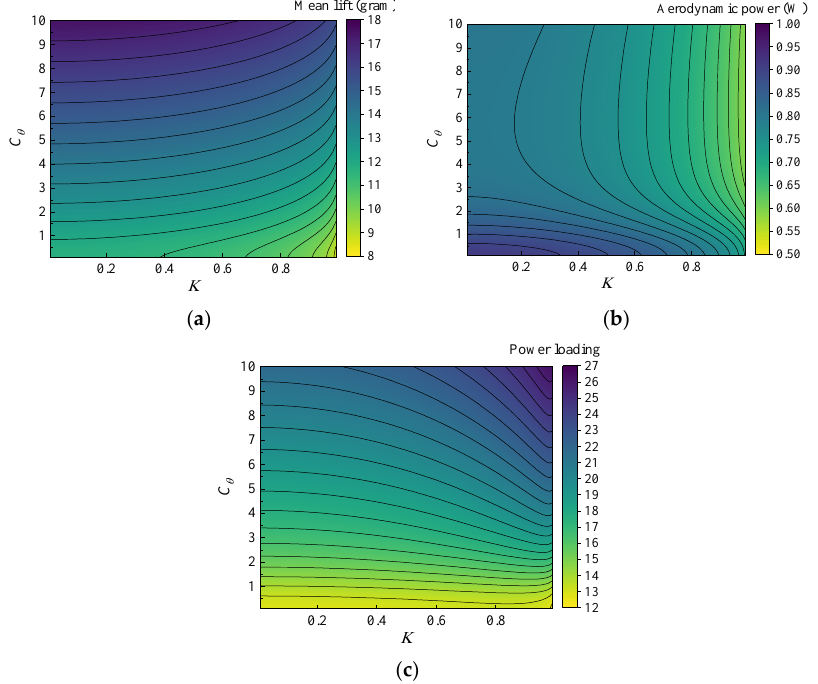
Figure 20. Parameter maps of aerodynamic performance as functions of K and C θ . ( a ) Lift with K and C θ . ( b ) Aerodynamic power with K and C θ . ( c ) Power loading with K and C θ .